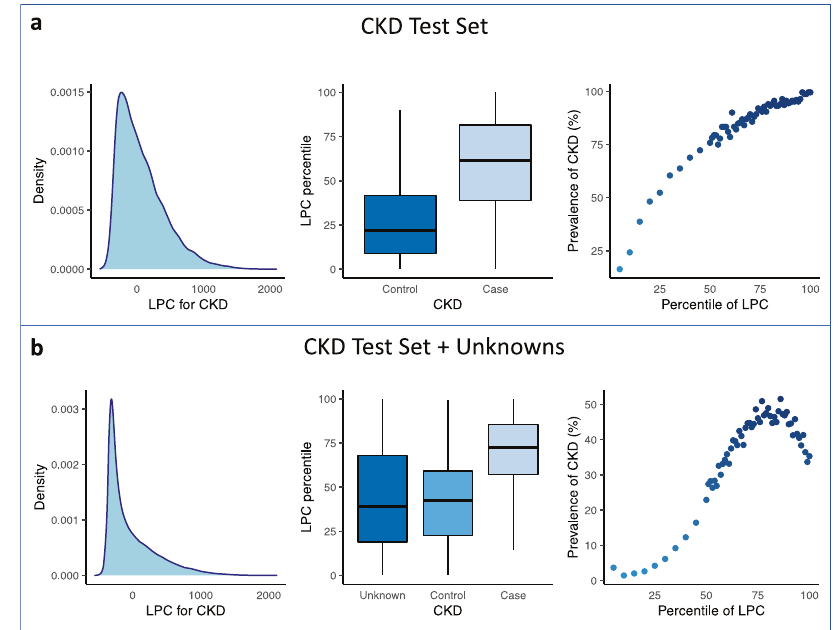
Fig. 4 Distribution of CKD LPC risk scores in the test set vs. test set + individuals with unknown status. Estimated density and distribution of LPC risk scores cases vs. controls in the a CKD test set and b with unknown status individuals added. LPC risk scores are derived based on all phecodes. Left, distribution of LPC risk scores. Middle, LPC risk score percentiles among cases vs. controls. Right, the prevalence of phenotype in 60 bins according to the percentiles of LPC risk scores. The center line, lower and upper bounds of the box represent the median, fi rst quartile ( Q 1 , or 25th percentile), and third quartile ( Q 3 , or 75th percentile) of the data, respectively. The whisker is drawn up (down) to the largest (smallest) observed point from the data that falls within 1.5 times the interquartile range ( = Q 3 − Q 1 ) above (below) the Q 3 ( Q 1 ). Table 2. Weights for ‘ relevant ’ phecodes vs. the rest of the phecodes.